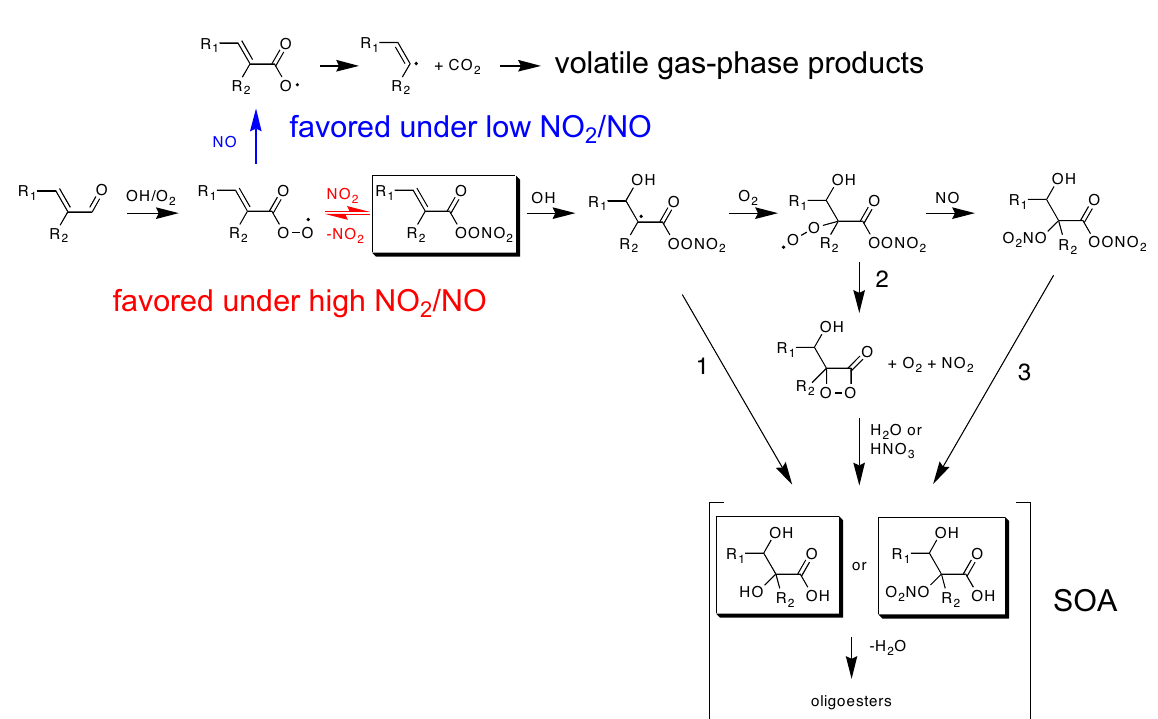
Fig. 10. Proposed mechanism to form aerosol-phase products from α,β -unsaturated aldehydes. The pathways highlighted in red are favored under high NO 2 /NO ratios and lead to aerosol formation. The pathways highlighted in blue are favored under low NO 2 /NO ratios and lead to fragmentation into volatile products. Aerosol formation from OH-reaction of unsaturated PANs can proceed via 3 possible routes (routes 1–3), and detailed investigation of each route is discussed in the main